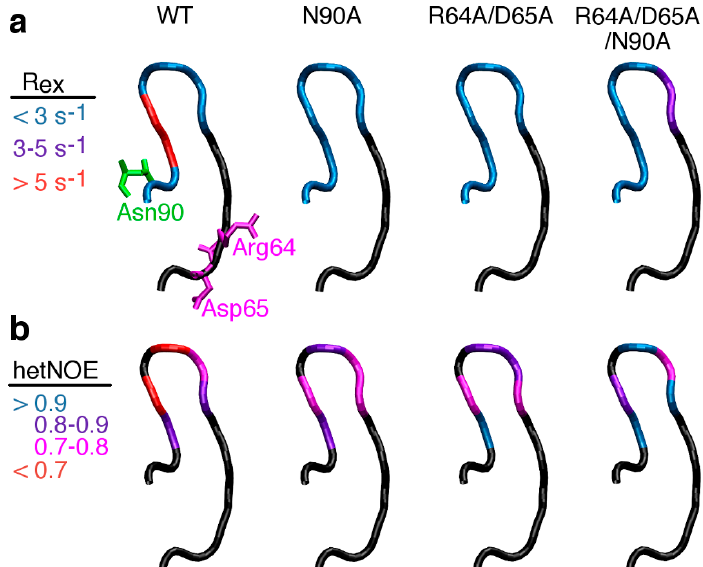
Figure 4. Disrupting β 1 α 1 loop interactions changes loop structural dynamics across multiple timescales. ( a ) Backbone positions on the β 1 α 1 loop are color coded according to the R ex value, which reports on the contribution of conformational exchange to the NMR R 2 relaxation rate. Blue, magenta and red colors report on R ex values of less than 3 s − 1 , between 3 and 5 s − 1 and greater than 5 s − 1 , respectively. Positions in black indicate that there is no data for these residues; ( b ) backbone positions on the β 1 α 1 loop are color coded according to the 1 H- 15 N heteronuclear Overhauser effects (hetNOEs); smaller hetNOE values generally correspond to less backbone structural ordering on the ps-ns timescale. Blue, purple, magenta and red colors report on hetNOE values greater than 0.9, between 0.8 and 0.9, between 0.7 and 0.8 and less than 0.7, respectively. Positions in black indicate that there is no data for these residues. NMR data were collected at 310 K on samples containing ~1 mM protein in 25 mM potassium phosphate pH 7.0, 75 mM KCl, 1 mM EDTA, 1 mM DTT, 0.02% NaN 3 and 10% ( v / v ) 2 H 2